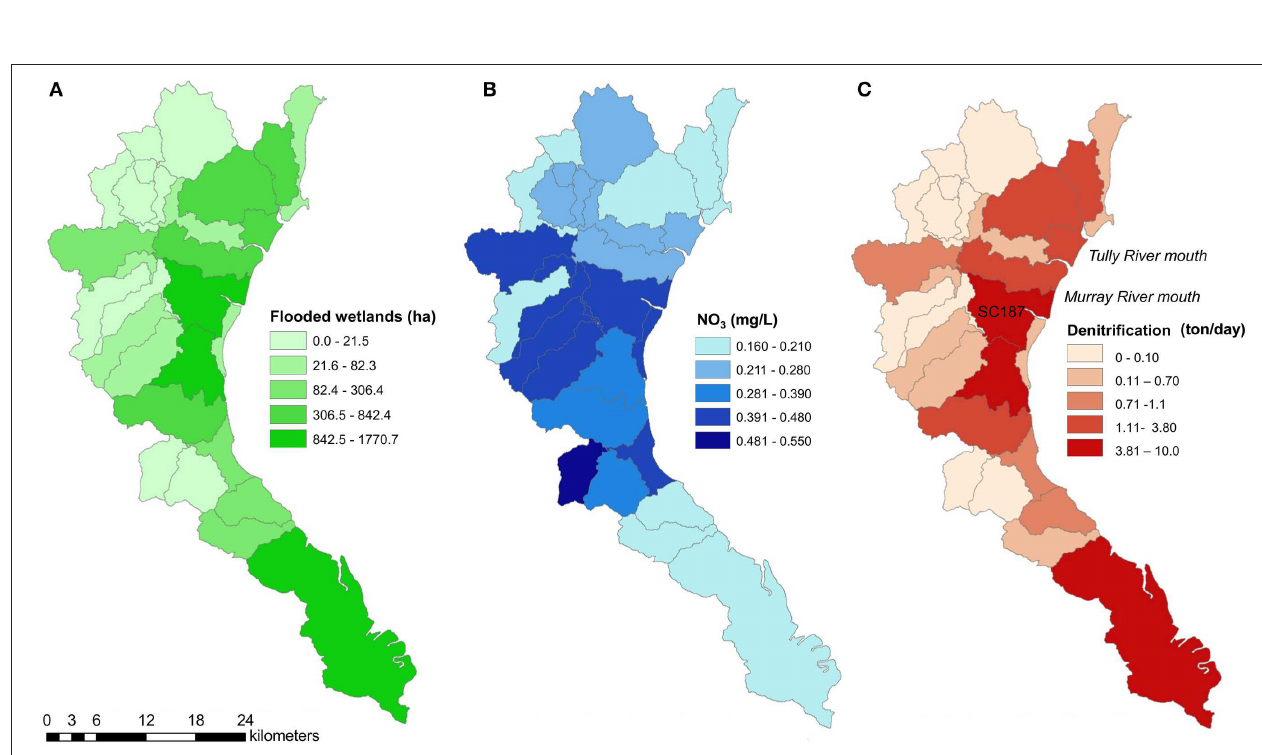
FIGURE 4 | (A) Area of flooded wetlands (ha); (B) mean NO − 3 -N concentrations (mg L − 1 ); and (C) denitrification potential (t NO − 3 -N d − 1 ) for sub-catchments of the Tully-Murray Rivers in tropical Australia during a flood event (March 30, 2018).